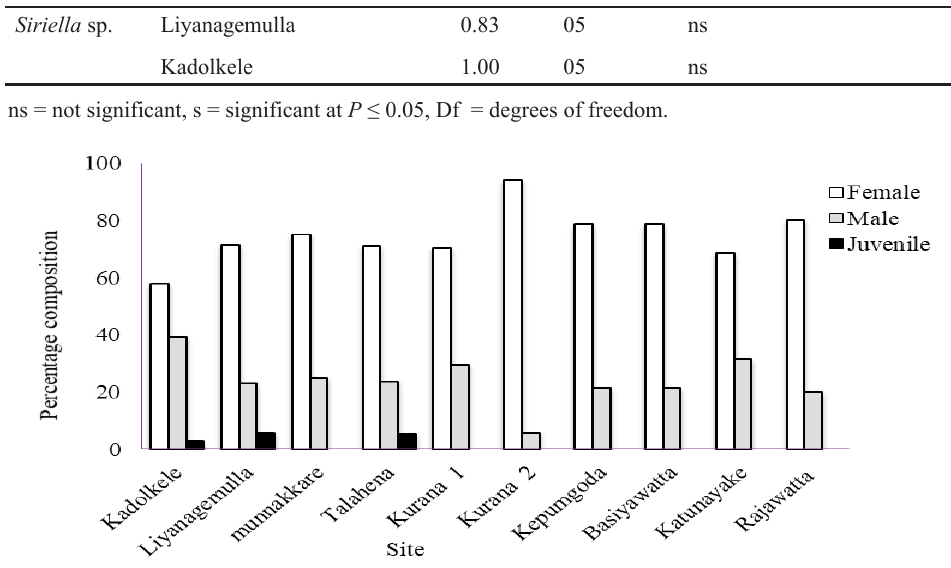
Figure 3: Percentage composition of male, female and juveniles in each site. Table 5: Pearson correlation coefficients (r) of bivariate analysis of the environmental parameters, stream edge condition, and .presence of garbage on mysid availability